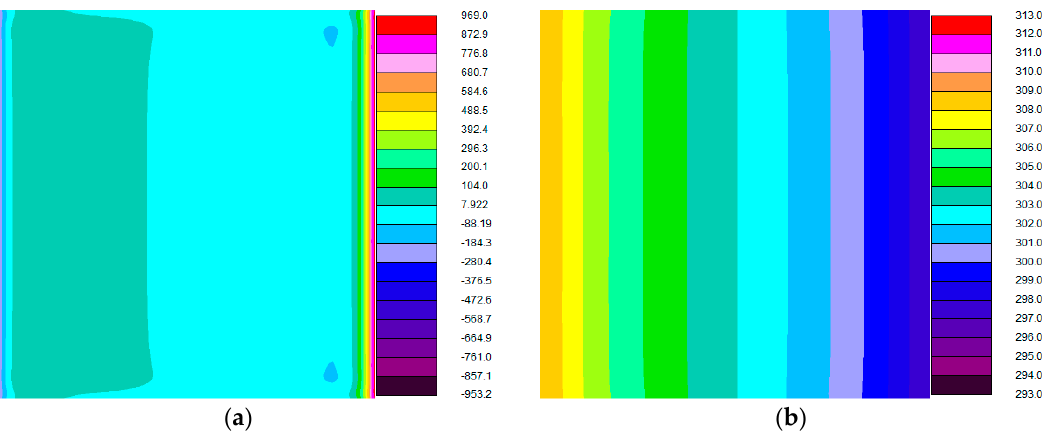
Figure 13. Counter-flow stainless-steel plate heat exchanger heat transfer model with LHC ( a ) The plate LHC heat flux distribution; ( b ) The plate temperature distribution.